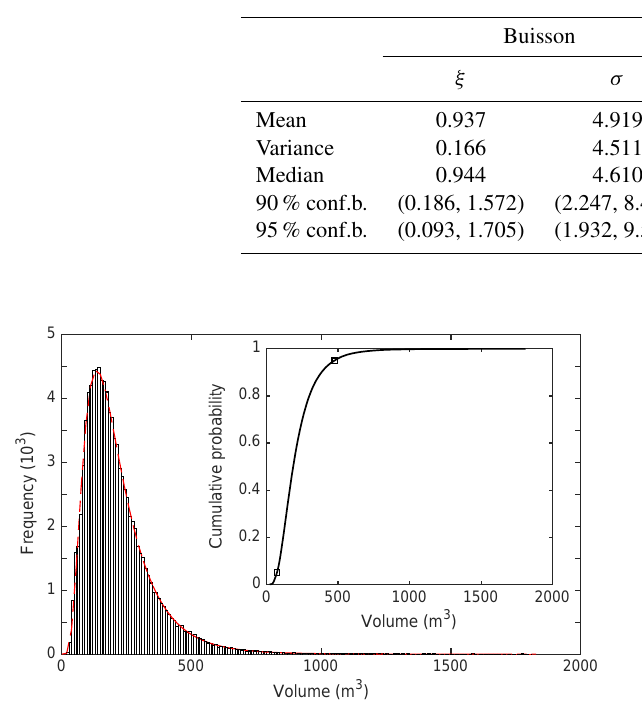
Figure 6. Histogram of the volumes having 1000 years return pe- riod fitted by a log-normal law (red dashed line). The empirical dis- tribution function is plotted in the box: the squares bound the 90% confidence interval.